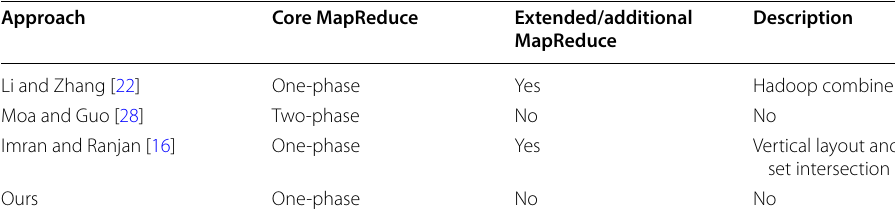
Table 1 Toward level-wise free MapReduce-based Apriori algorithms